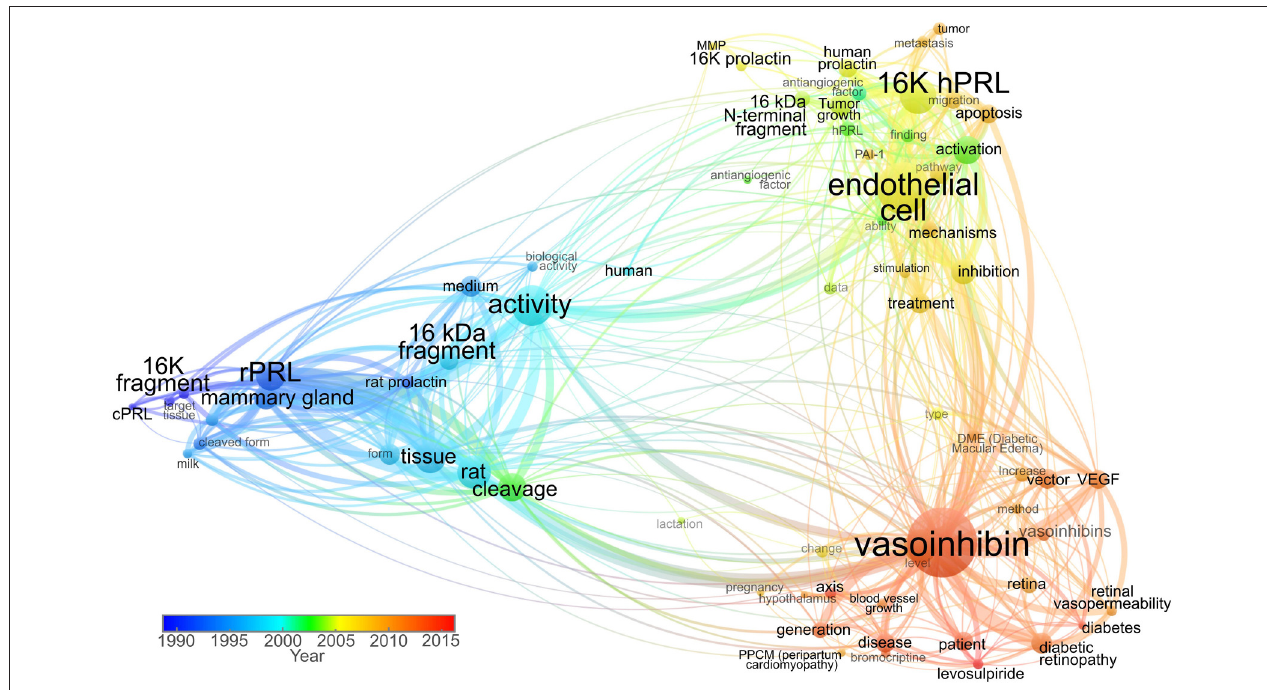
FIGURE 1 | Term co-occurrence map analyzing the use of vasoinhibin-related names in titles and abstracts throughout time. Scientific articles published between 1980 and 1999 used terms such as “16K fragment,” “cPRL” (cleaved prolactin), and “16 kDa fragment” as valid nomenclature. The predominant “16K hPRL” term was then used in combination with “16K prolactin” and “16 kDa N-terminal fragment” up to 2006, when the “vasoinhibin” term was introduced. In recent years, the “vasoinhibin” word shows higher frequency, whereas the 16K-related shows progressive lower incidence. The size of the node represents the frequency of term appearance. The lines between terms indicate relations with smaller distances representing stronger associations. The color indicates average year of term appearance. The map was created and visualized using VOSviewer software tool ( 47) in which the network was constructed employing 71 terms with more than 60% relevance, selected from 119 words surpassing the seven-appearance threshold, in titles and abstracts of 93 research publications accessed through